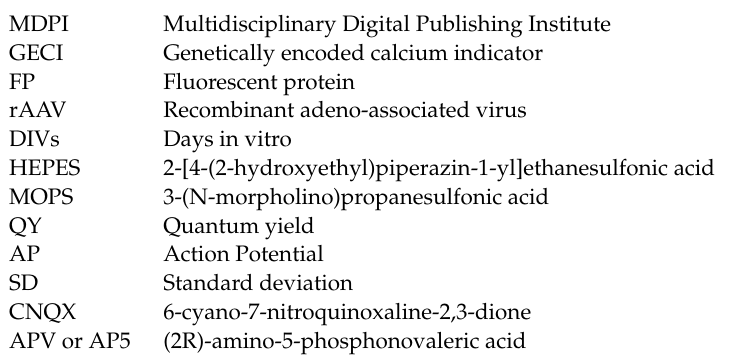
Figure S2: Calcium titration curves for R-GECO1; Figure S3: Photochromism in the FRCaMPsat indicator; Figure S4: Calcium imaging of non-specific (spontaneous) activity of neuronal cultures co-expressing the FRCaMP and NCaMP7 calcium indicators; Figure S5: Puncta-like localization of the red FRCaMP indicator co-expressing with green NCaMP7 in cultured neurons; Figure S6: Localization and time-lapse response of the split-version of the FRCaMP indicator to Ca2+ variations in HeLa cells depending on the presence of the heterodimerizing (bJun-FRCaMPC/bFos-FRCaMPN) or non-heterodimerizing (bJun-FRCaMPC/bFOS ∆ Zip-FRCaMPN) pair; Figure S7: Brightness of the split-version of the FRCaMP indicator at low Ca 2+ concentrations in HeLa cells depending on the the presence of the heterodimerizing (bJun-FRCaMPC/bFos-FRCaMPN) or non-heterodimerizing (bJun-FRCaMPC/bFOS ∆ Zip-FRCaMPN)